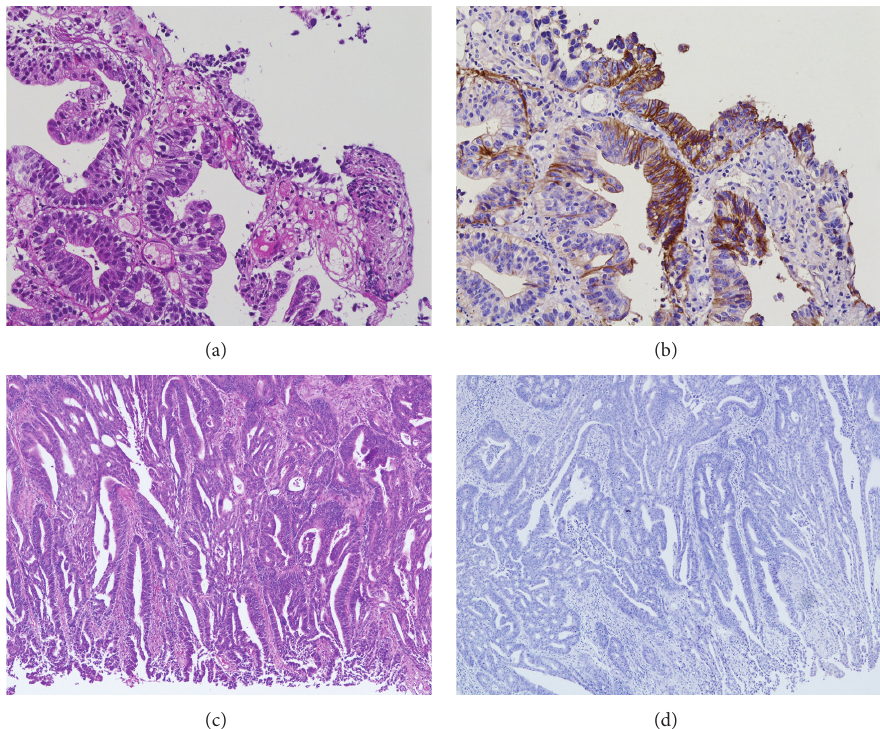
Figure 2: Microscopic findings of gastric cancer. (a) and (b) show biopsy specimens at presentation. (a) Histological findings show a well-differentiated tubular adenocarcinoma (hematoxylin and eosin staining, original magnification × 40). (b) Immunohistological findings of HER2 immunostaining show strong basolateral membrane reactivity with heterogeneity. The gastric cancer is scored as 3+ by HER2 immunohistochemistry scoring criteria (original magnification × 40). (c) and (d) show the resected specimen after chemotherapy including trastuzumab. (c) Histological findings show a moderately differentiated tubular adenocarcinoma invading into the subserosa (hematoxylin and eosin staining, original magnification × 40). (d) Immunohistological findings of HER2 immunostaining showed no membranous reactivity in any tumor cells (original magnification ×